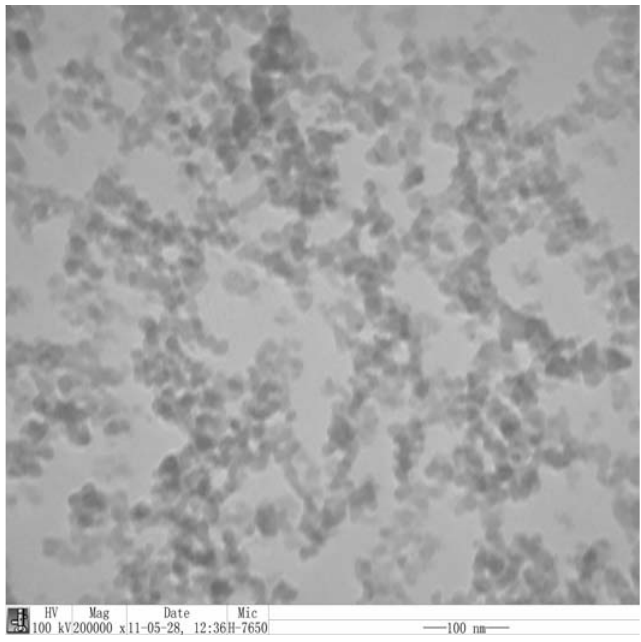
Figure 2. Transmission electron microscopy (TEM) of the nanoscale silica in the solution.